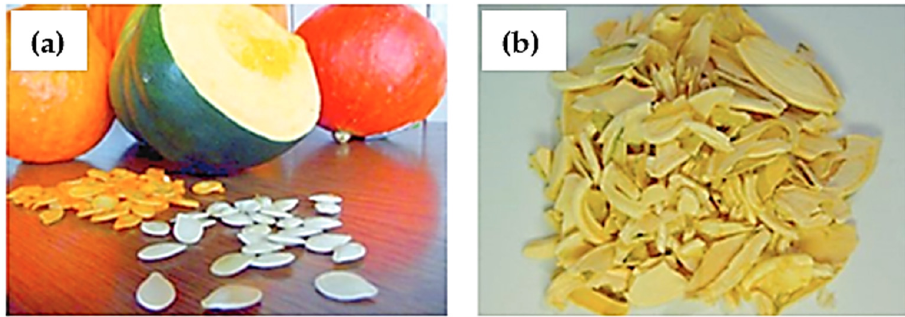
Figure 1. General view of ( a ) pumpkins and their seeds and ( b ) pumpkin seed hulls.